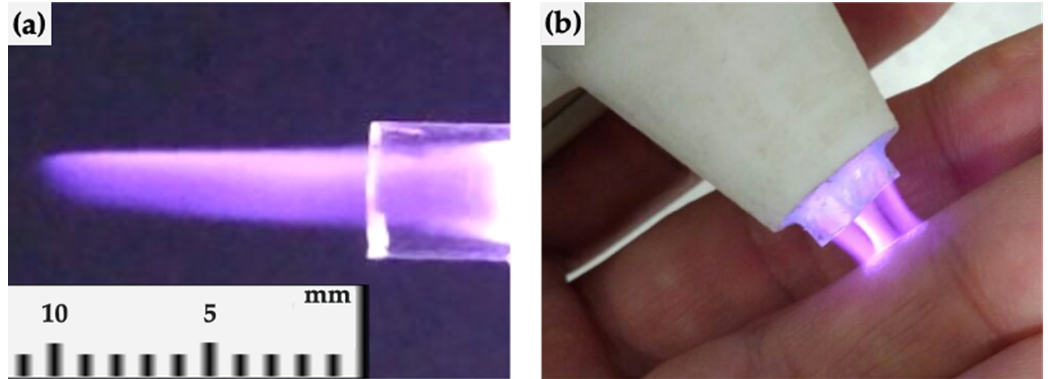
Figure 5. ( a )—Helium plasma jet at short pulse excitation, ( b )—three-channel plasma jet.